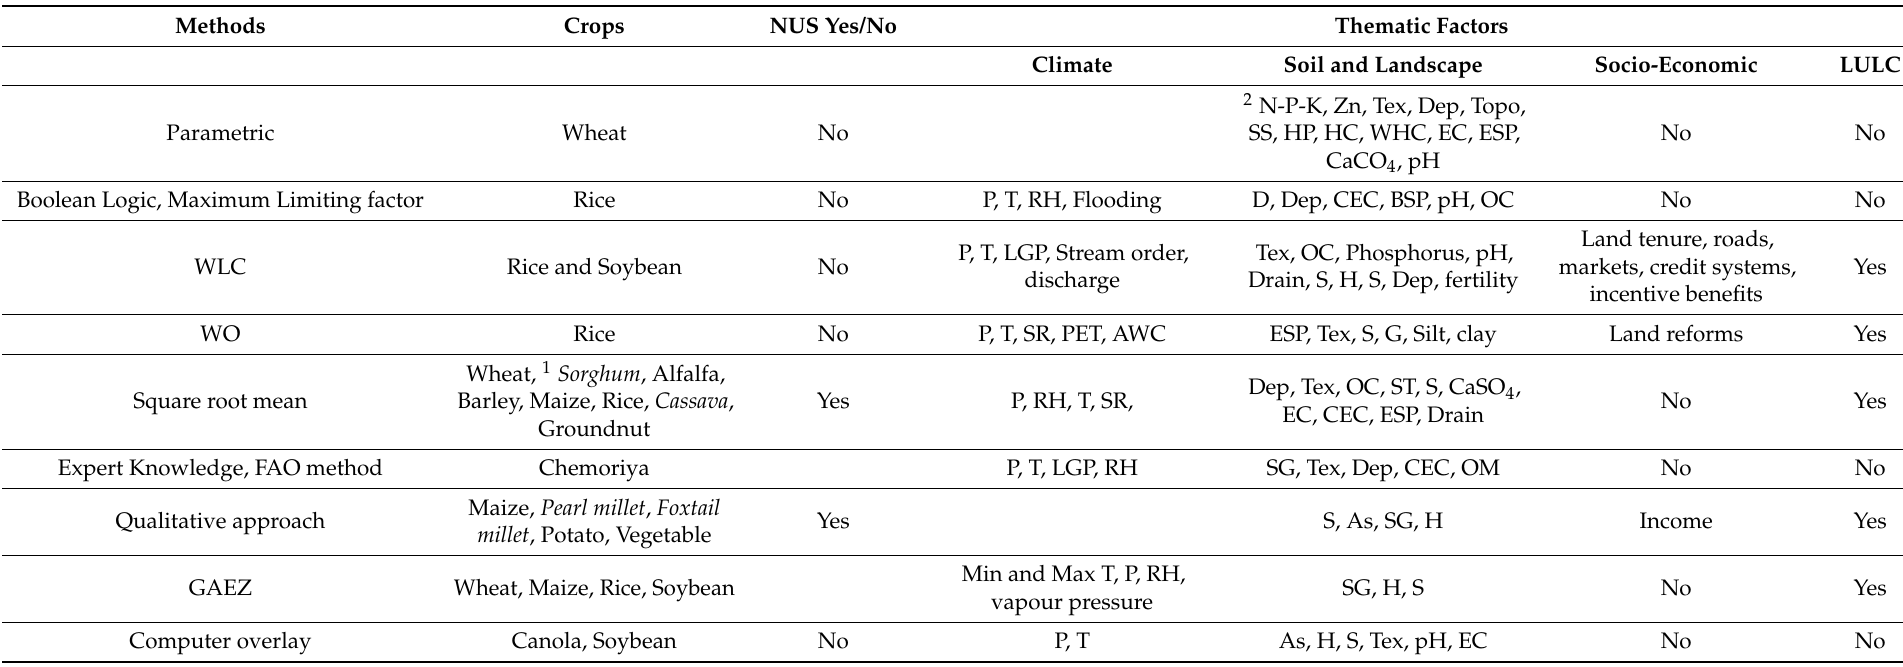
Table 2. Description of traditional methods used in land suitability